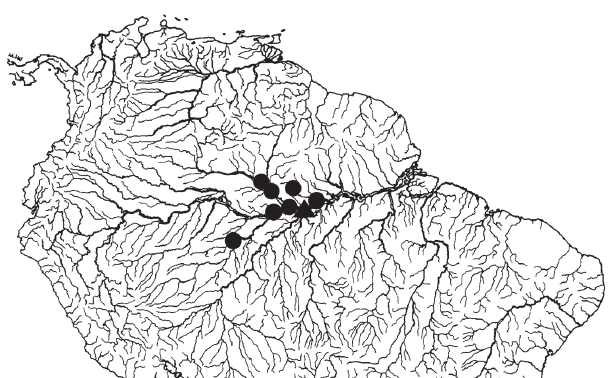
Fig. 4. Drainage map of northern South America illustrating the geographic distribution of Ageneiosus uranophthalmus . Type locality represented by triangle. Some symbols represent more than one locality or lot of specimens. Base map by Marilyn